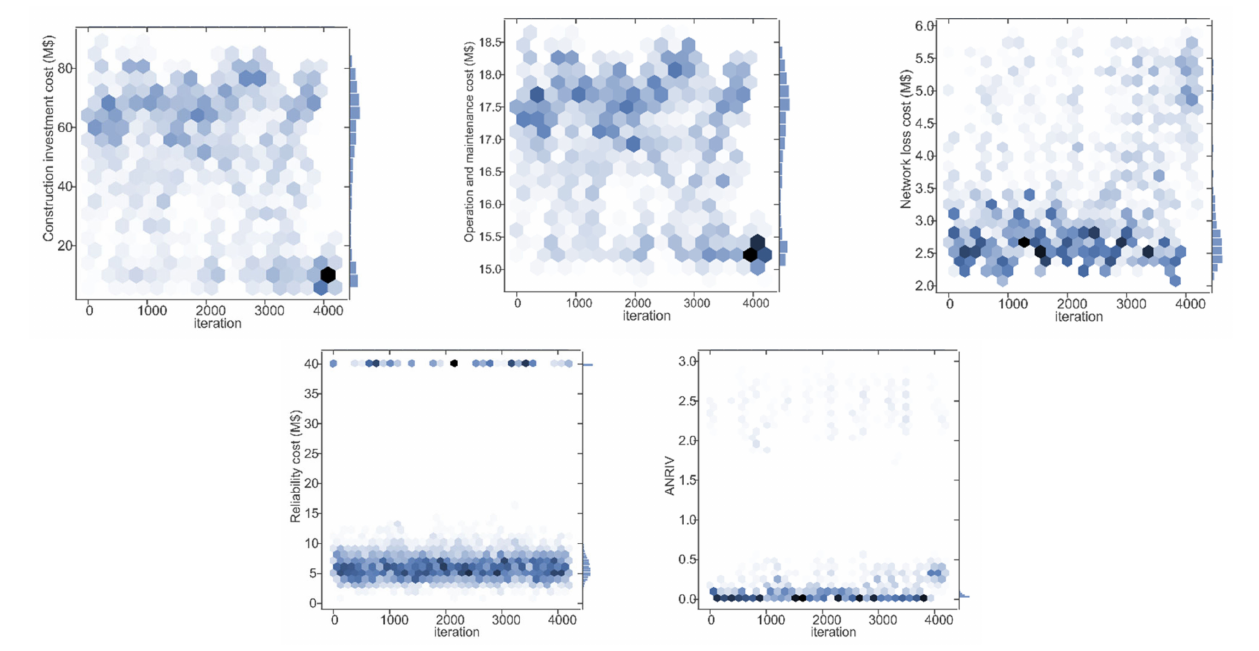
Figure 7. Changes of each index with